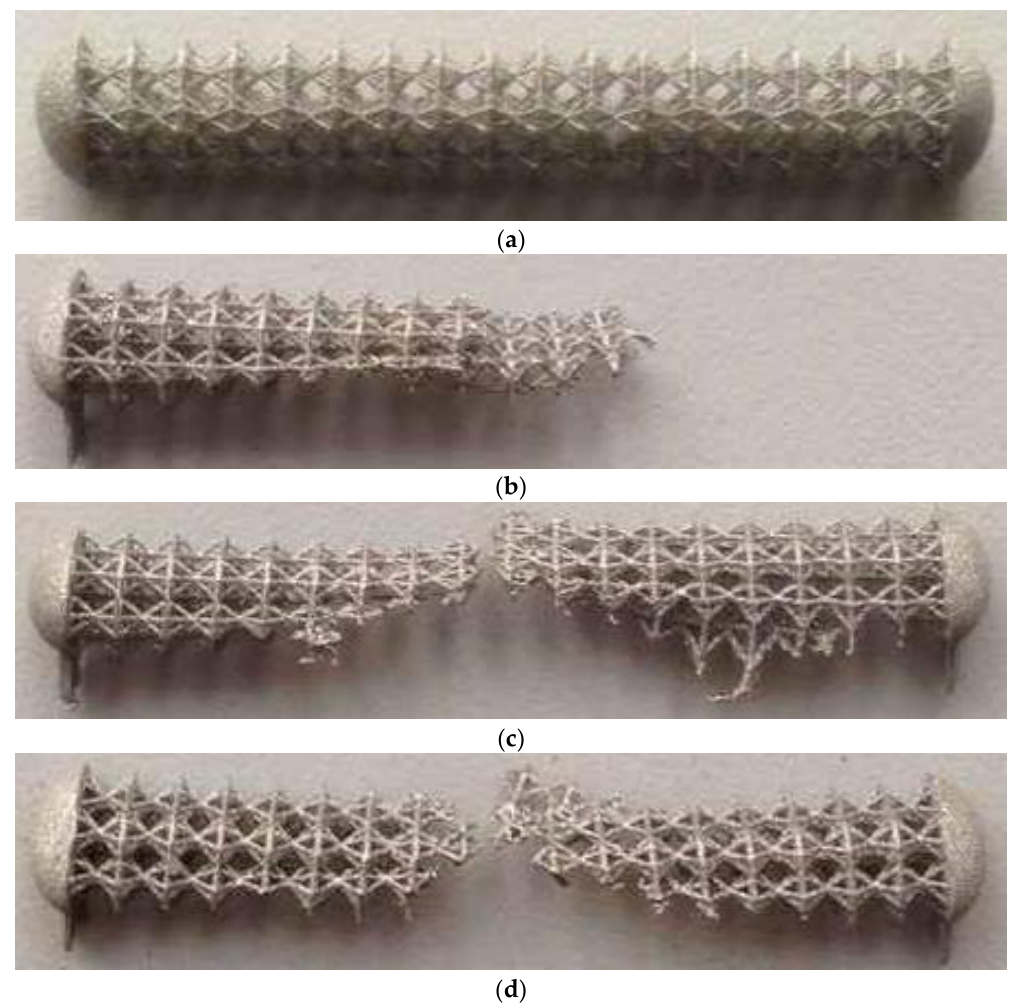
Figure 6. Results of manufacturing: Growth with the angle of 45° to vertical ( a ), growth with vertical orientation ( b ), growth with horizontal orientation ( c ), growth with the angle of 60° to vertical ( d ).